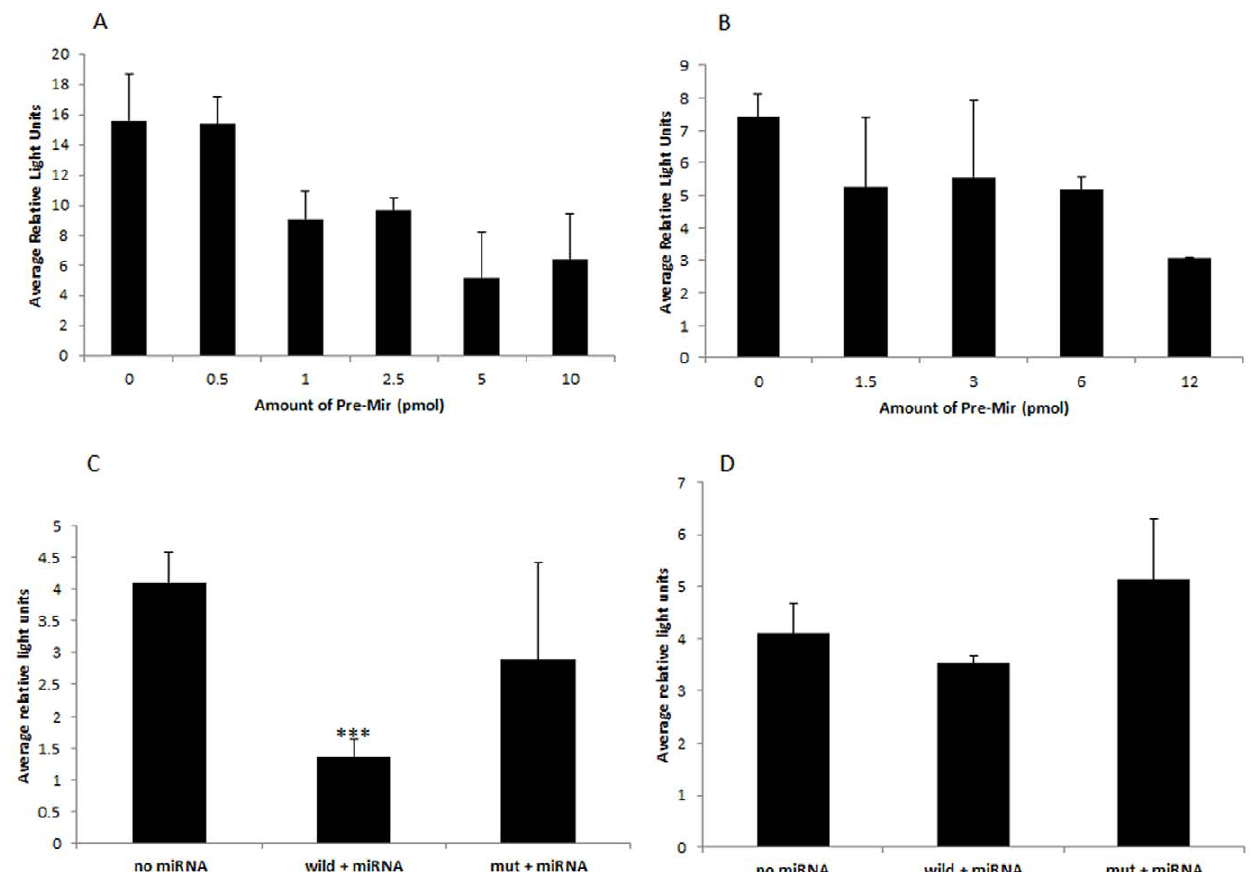
Figure 10. A: Dose-dependent inhibition of Eps15 expression in the Luciferase Assay after transfection of HEK-293 cells with miR- 186. B: Dose-dependent inhibition of the Nab1 gene in the Luciferase Assay after transfection of MCF7 cells with miR-709. C: Luciferase Assay with pFN4 (3 9 UTR Eps15 ) and miR-186. The first bar demonstrates relative level of luciferase activity after transfection of MCF-7 cells with pFN4 only. Second bar: pFN4 + miR-186. Third bar: pFN4 mut + miR-186. Asterisks represent statistical significance (p , 0.001). D: Luciferase Assay with pFN7 (3 9 UTR Nab1 ) and miR-709. The first bar demonstrates relative level of luciferase activity after transfection of MCF-7 cells with pFN7 only. Second bar: pFN7 + miR-709. Third bar: pFN7 mut + miR-709. Bars represent the normalized average of relative luciferase units.